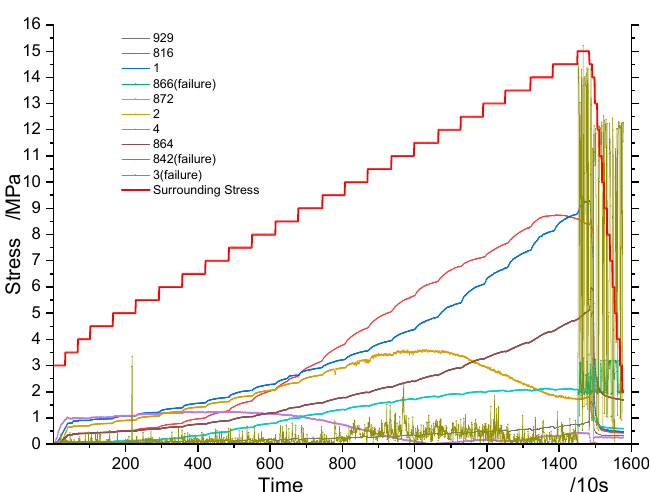
Figure 7. Stress change curve of the stress monitoring point.